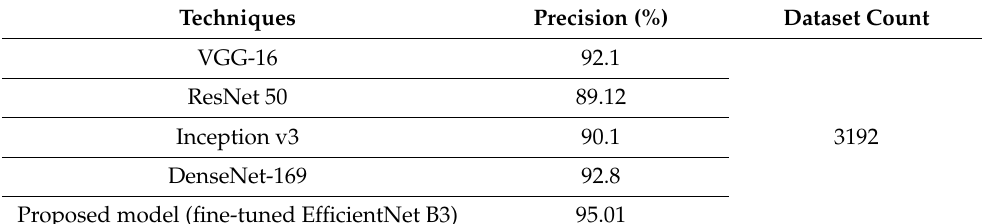
Table 5. Precision calculation for detection of monkeypox disease